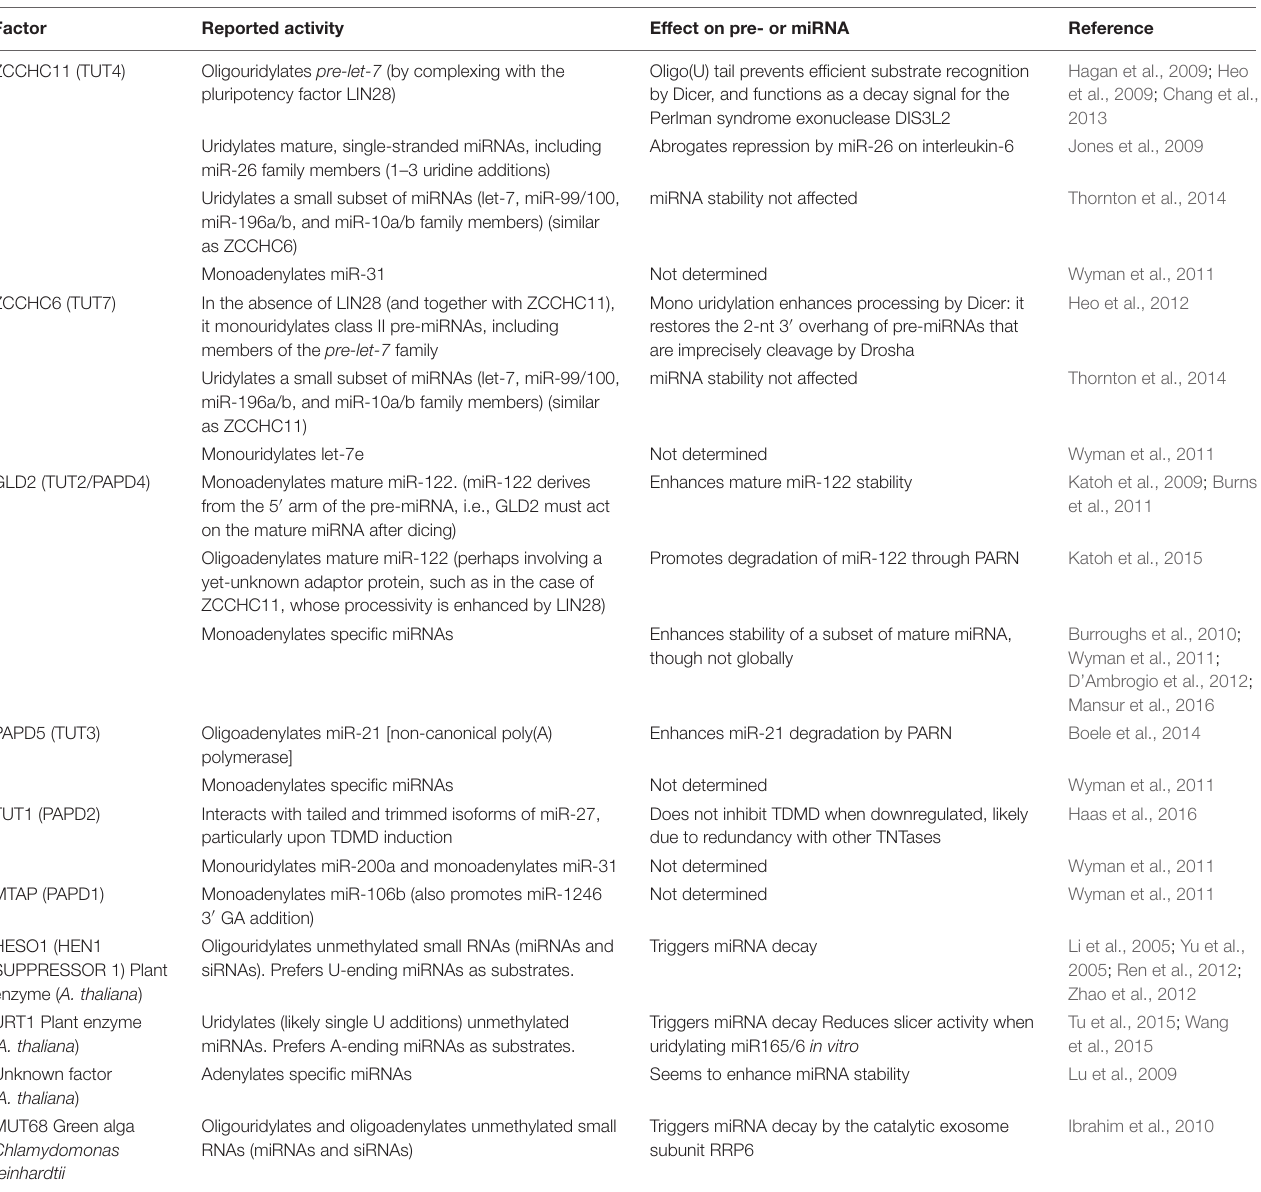
TABLE 1 | TNTases affecting miRNA 3 (cid:48)